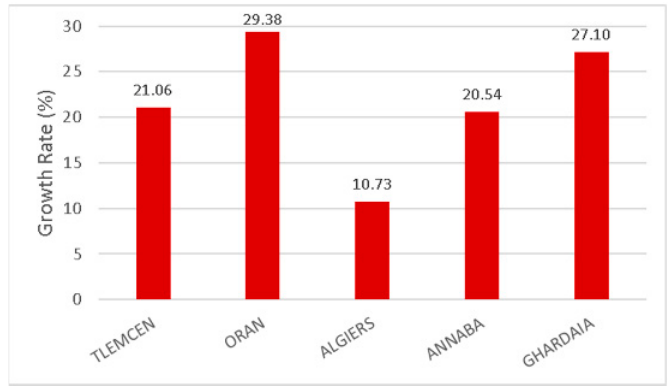
Figure 2. Population growth rate of the five wilayas between 2008 and 2018.